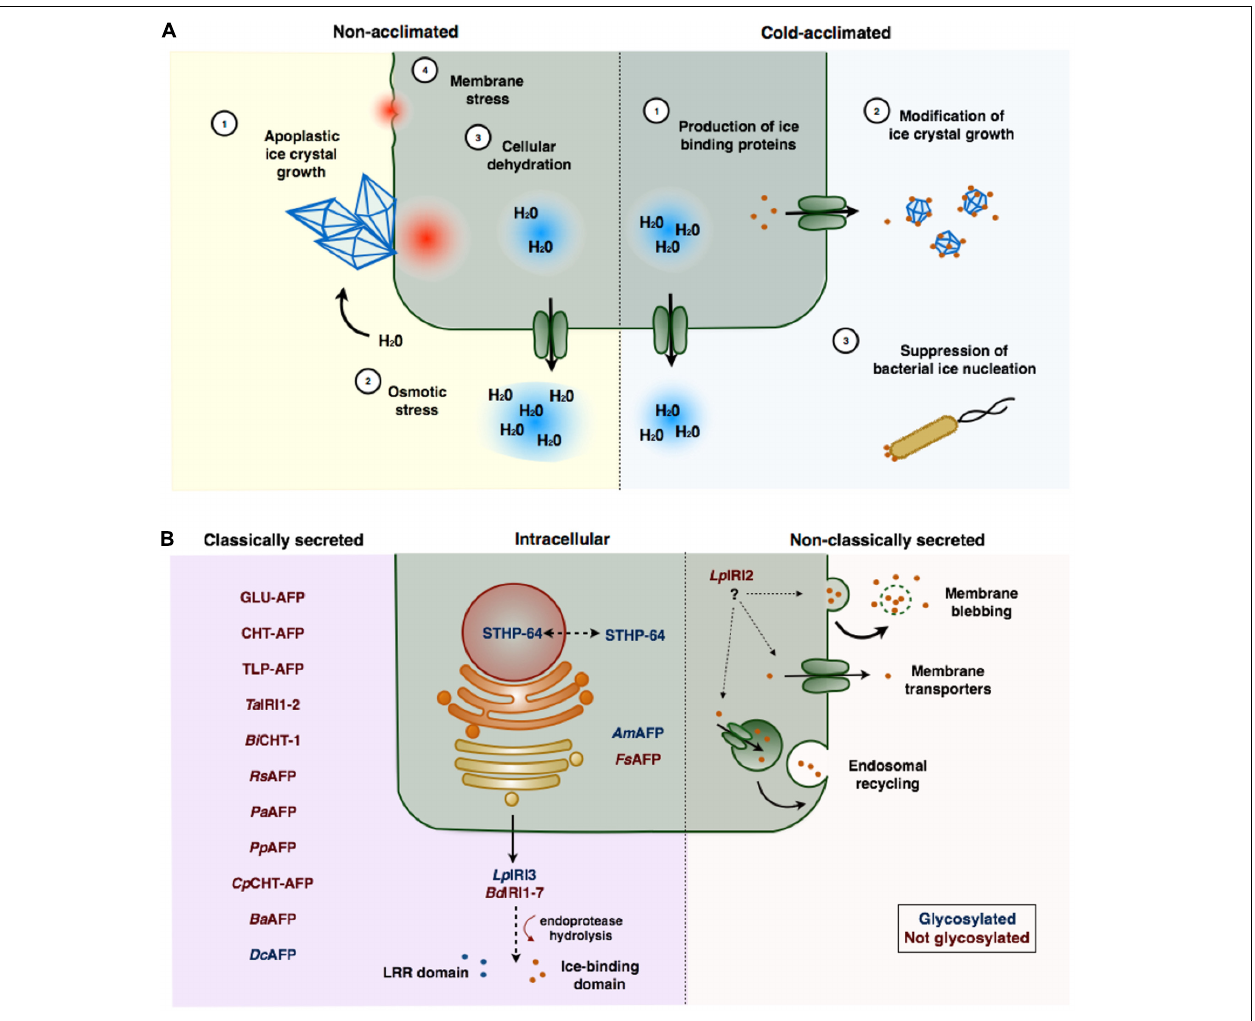
FIGURE 1 | (A) Freezing stress and ice-binding proteins (IBP)-induced freeze protection in plants. In the absence of IBPs, large ice crystals form in the apoplast that can physically damage plasma membranes (1). As water molecules join the ice crystal lattice an osmotic gradient is formed (2) resulting in the sequestration of intracellular water, and consequent cellular dehydration (3). The loss of cell volume may cause cells to collapse or rupture (4). Cold acclimation induced expression of IBPs, which are typically secreted to the apoplast (1), adsorb to seed ice crystals preventing their growth (2). IBPs may also prevent freezing associated with bacterial ice nucleation (3). (B) Localization and post-translational modification of ice-binding proteins in plants. Most plant IBPs contain amino-terminal secretion signals and are localized to the apoplast through the endoplasmic reticulum (ER)–Golgi apparatus pathway. Some of these proteins (LpIRI3 and BdIRI1-7), appear to be hydrolyzed following secretion, releasing an LRR domain from the ice-binding domain. LpIRI2, which lacks a signal peptide, is secreted, likely through a non-classical secretion pathway. Few IBPs have been localized to the intracellular space. Glycosylated proteins are indicated in red, proteins that are not glycosylated are indicated in blue. IBPs are named according to Table 1